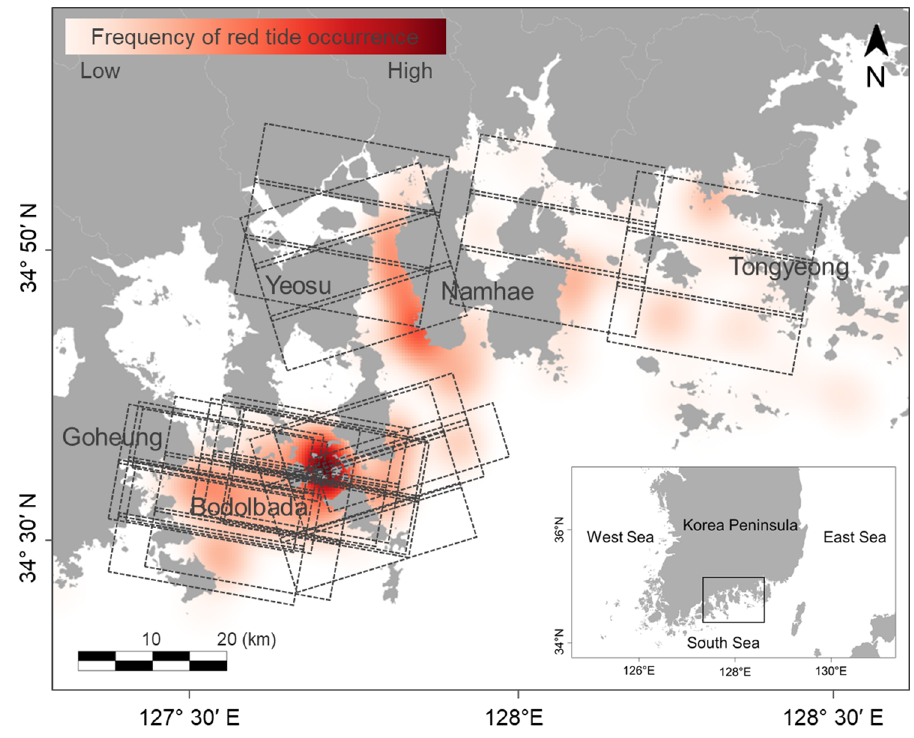
Figure 1. The study area covers the southern coast of Korea, including Goeung, Yeosu, Namhae, and Tongyeong. Black dotted boxes show the acquisition area in PlanetScope imagery between 24 July and 2 August in 2018. The frequency map shows the main regions of red tide occurrence in 2018. These data come from the red tide daily reports provided by NIFS.